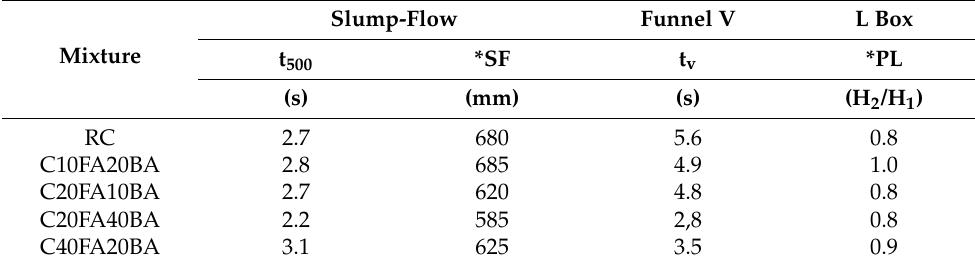
Table 3. Fresh concrete properties, slump-flow, funnel V and L box (*SF—spread classes and *PL— classes of the capacity of passage in the box L).